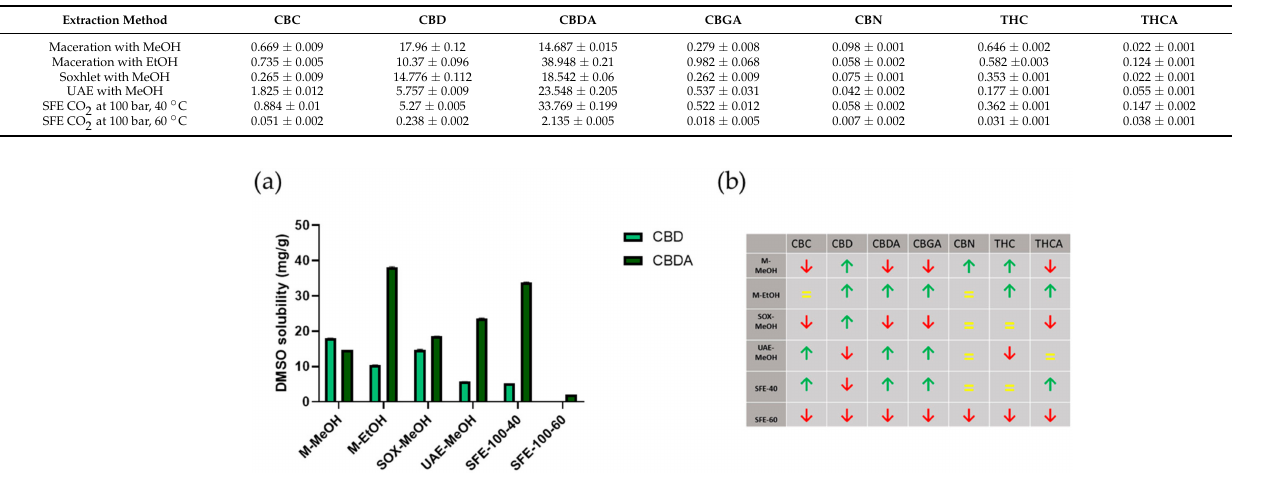
Figure 3. Comparison of cannabinoid content in Cannabis sativa extracts dissolved in DMSO. Panel ( a ) shows CBD and CBDA solubility in DMSO between different extraction methods (data are means ± SD from n = 3 replicate measurements). Panel ( b ) shows the trends of all cannabinoids dissolved in DMSO across extraction methods tested compared to the average (= means as the average, ↑ above average, and ↓ below average).